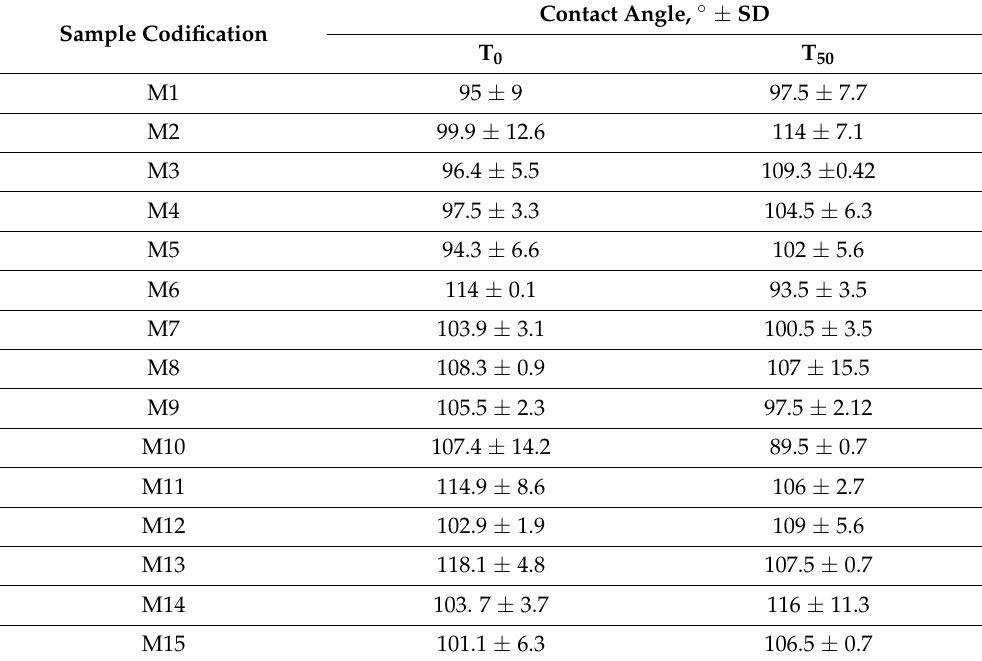
Table 4. Contact angle of PET composites pellets before (T 0 ) and after 50 days of collagen immersion (T 50